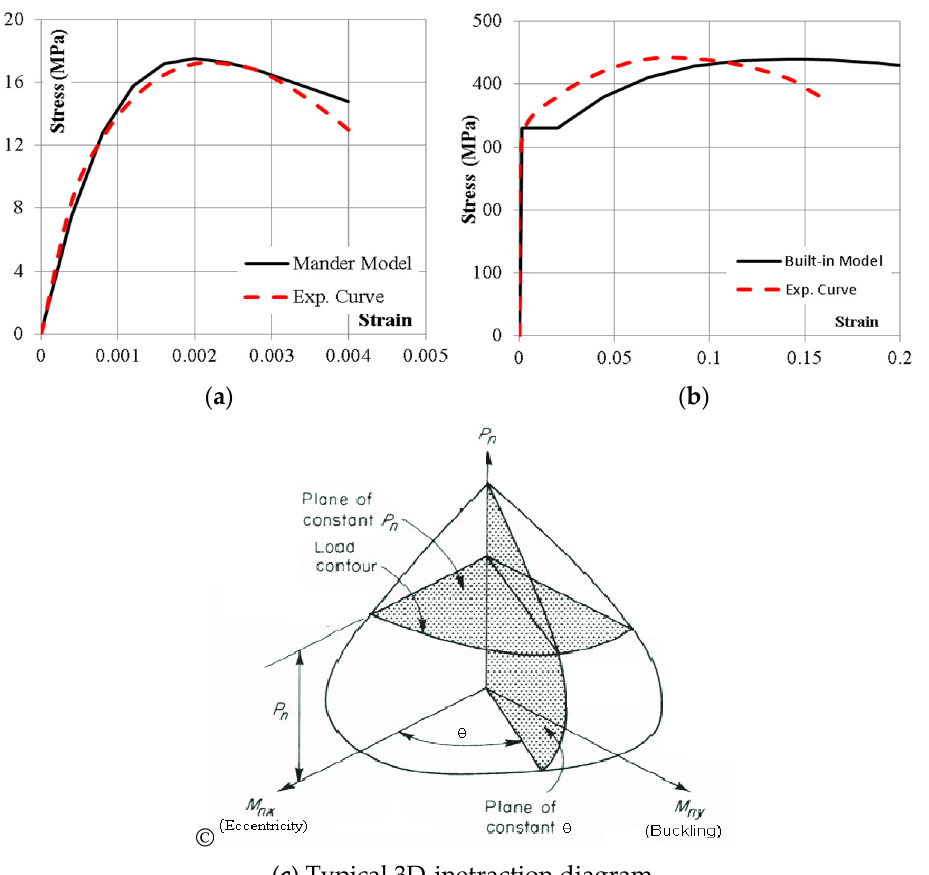
Figure 6. Used material modes ( a ) for concrete, ( b ) for steel and ( c ) typical 3D interaction diagram.